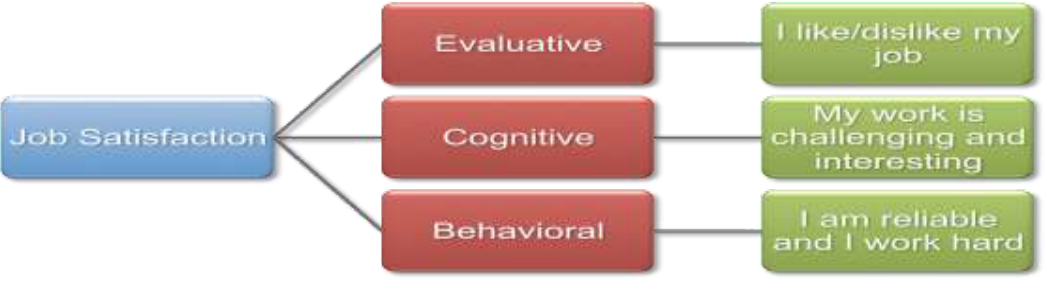
Figure 1: Components of Job